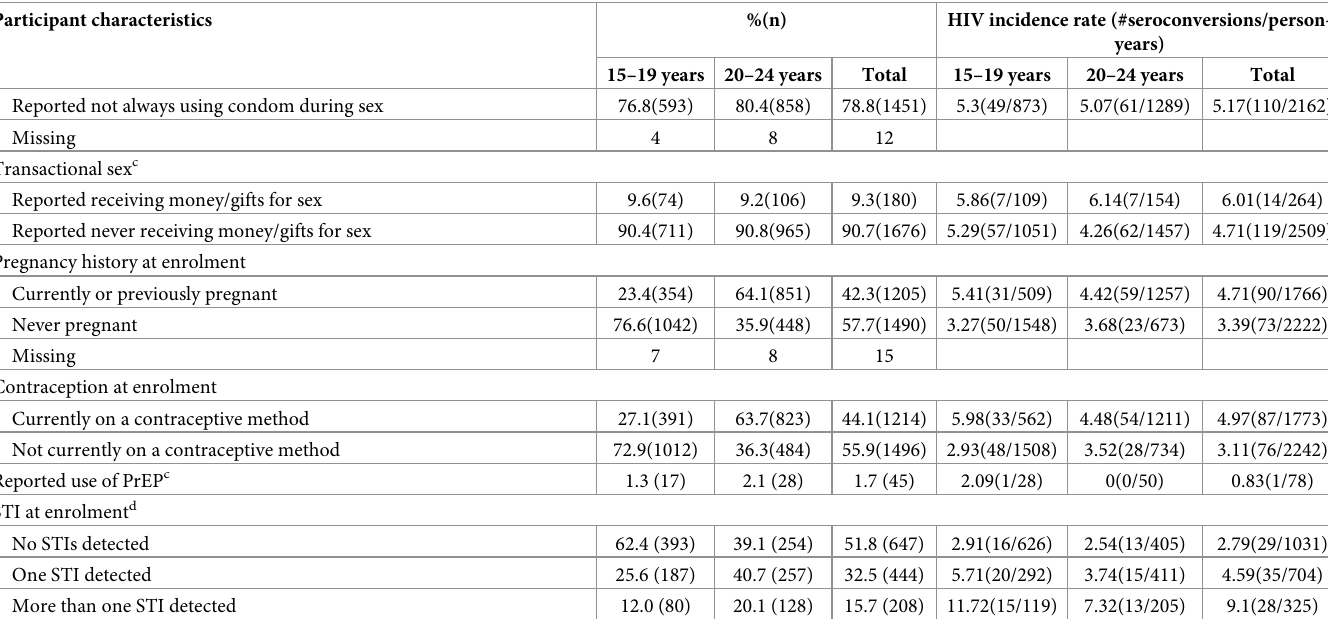
Almost a third of AGYW aged 20-24-year-olds had not yet completed secondary school although their age exceeded the age-norm of secondary schools. Among them, the HIV inci- dence rate was 5.94 (95% CI: 3.96–8.89) per 100 person-years. Just under 2% (n = 48) of all AGYW reported knowingly having had sex with an individual who was HIV positive and not on ART and of these AGYW, 25% (n = 12) seroconverted during follow-up. Compared to those with follow-up data, HIV-negative AGYW who were not available for follow-up (n = 808, 23.0%) were more likely to be aged between 20 and 24 (48.2% versus 54.7%) and reside in a rural area (51.7% versus 76.6%). However, the two groups were compa- rable with respect to education levels, household income, number of lifetime sexual partner- ships and STI status at baseline.